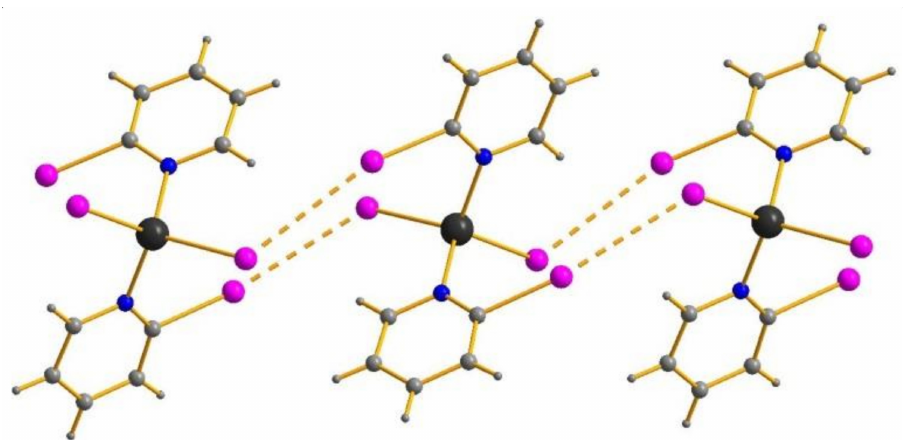
Figure 3. I ··· I contacts (dashed) in the structure of 9 . Table 2. Isostructural complexes of [(2-XL) 2 MY 2 ] series. M L Y Isostructural To